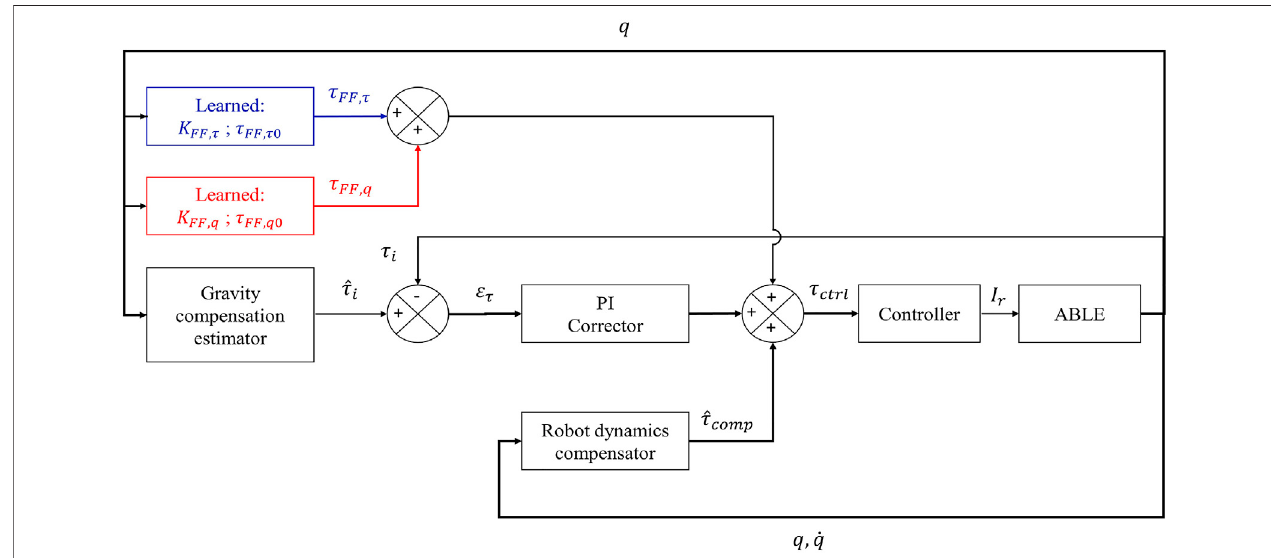
FIGURE 4 | Control schemes used during the present study. Black: basic PI control loop and weight torque estimation. Blue: FFTF term. Red: FFCM term.